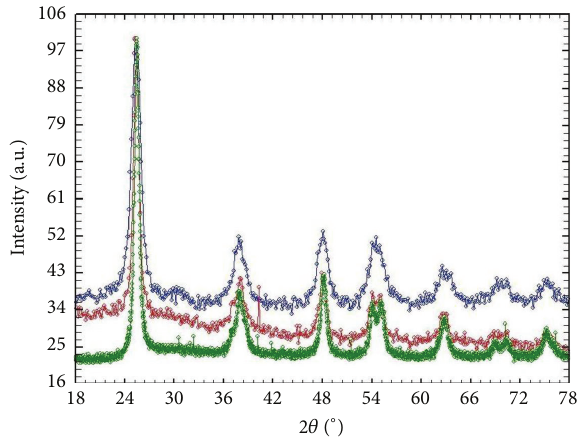
Figure 1: XRPD spectra of samples of anatase (red) and TiO 2 15% N doped anatase (blue) and anatase Pearson’s crystal data